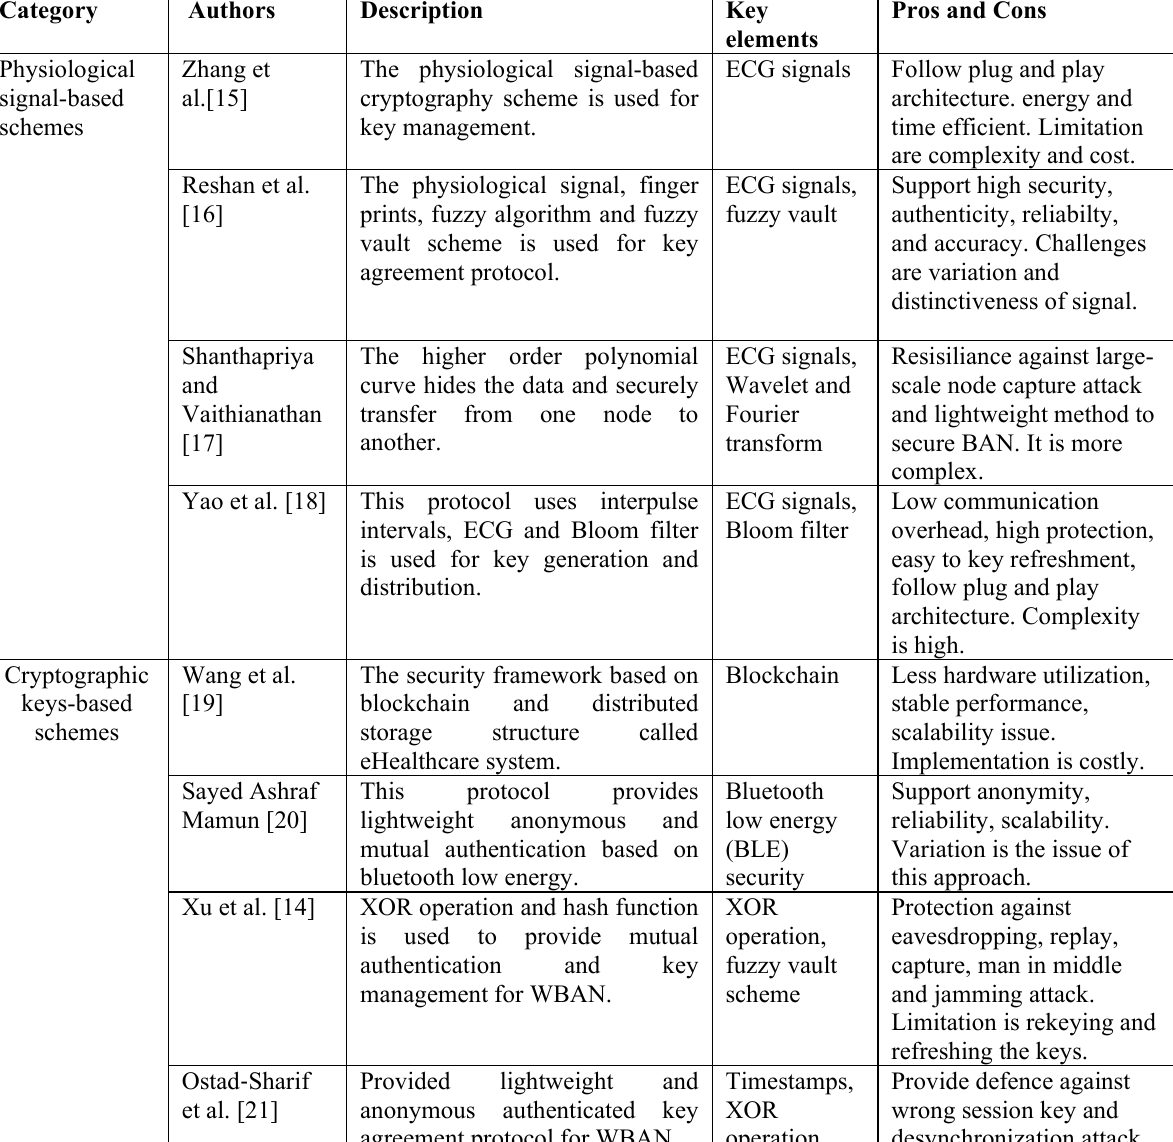
Table 1. Comparison of various security approaches in